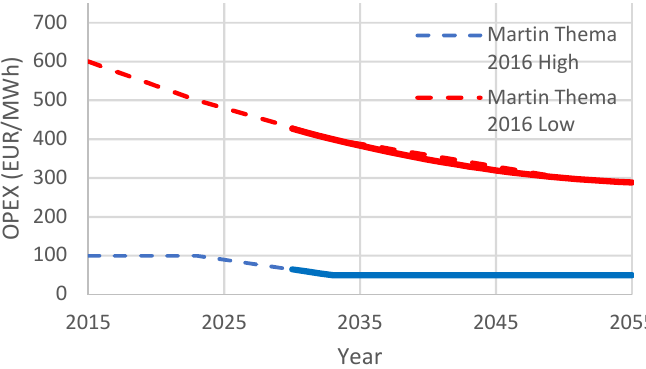
Figure 7. OPEX for PtG system from 2020 to 2050.